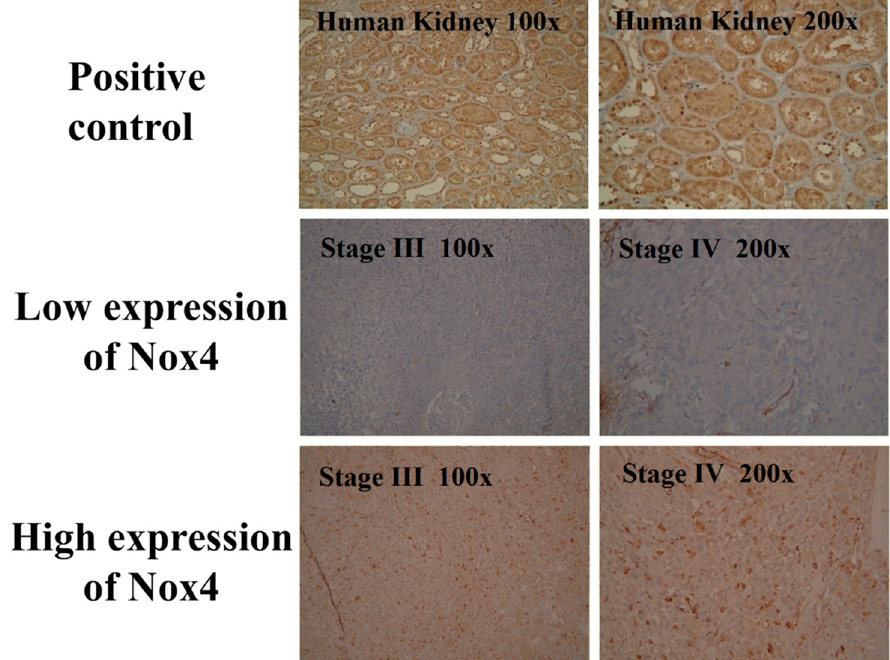
Figure 3. Immunohistochemical analysis of Nox4 expression in patients with oral tongue squamous cell carcinoma.